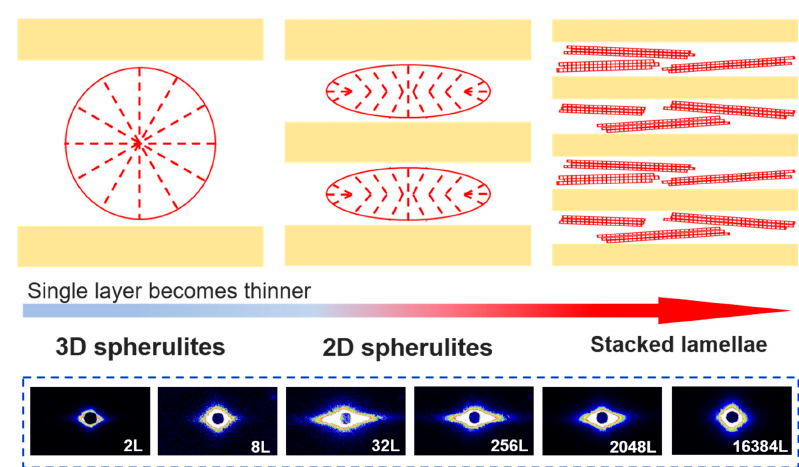
Figure 4. ( a ) WAXD profiles for coextruded PVDF-HFP/PC films varying the nominal number of layers. The intensity was normalized with film thicknesses. ( b ) FTIR spectra of PVDF-HFP/PC films. DSC thermographs of; ( c ) heating scan; and ( d ) cooling scan for coextruded PVDF-HFP/PC films.